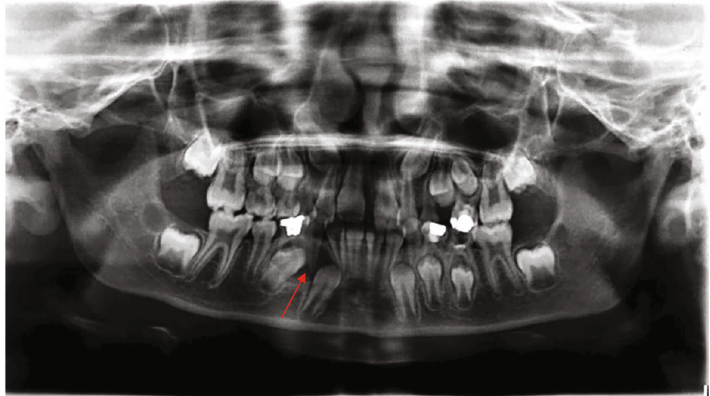
Figure 1: Preoperative panoramic radiograph (red